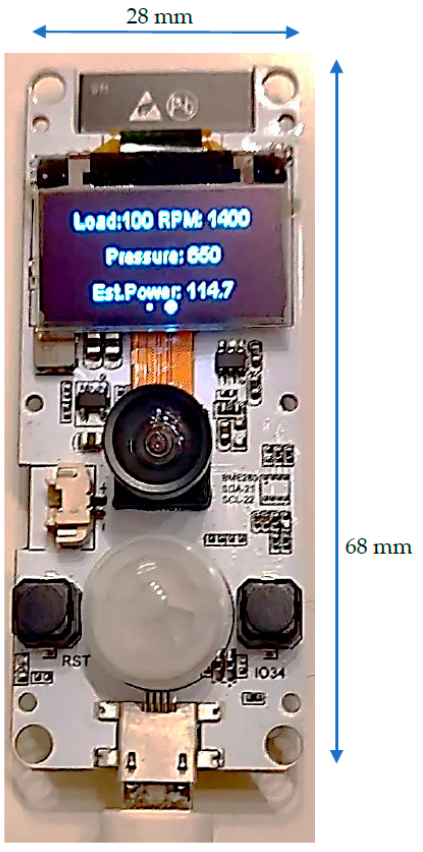
Figure 15. “AI in a nutshell” solution with an effective power (Pe) = 114.7 kW computed by the embedded ANN for load = 100%, speed = 1400 rpm, and pressure p = 650 mmWC.